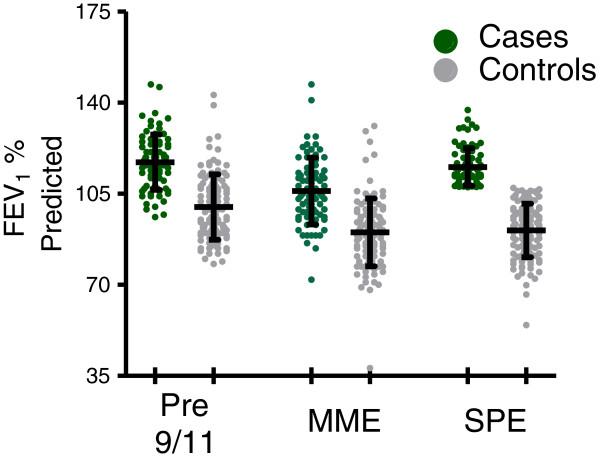
FEV1% predicted of cases and controls over time. Mean (SD) expressed for cases n = 77 (green) and controls n = 111 (grey) at Pre-9/11, MME and SPE.